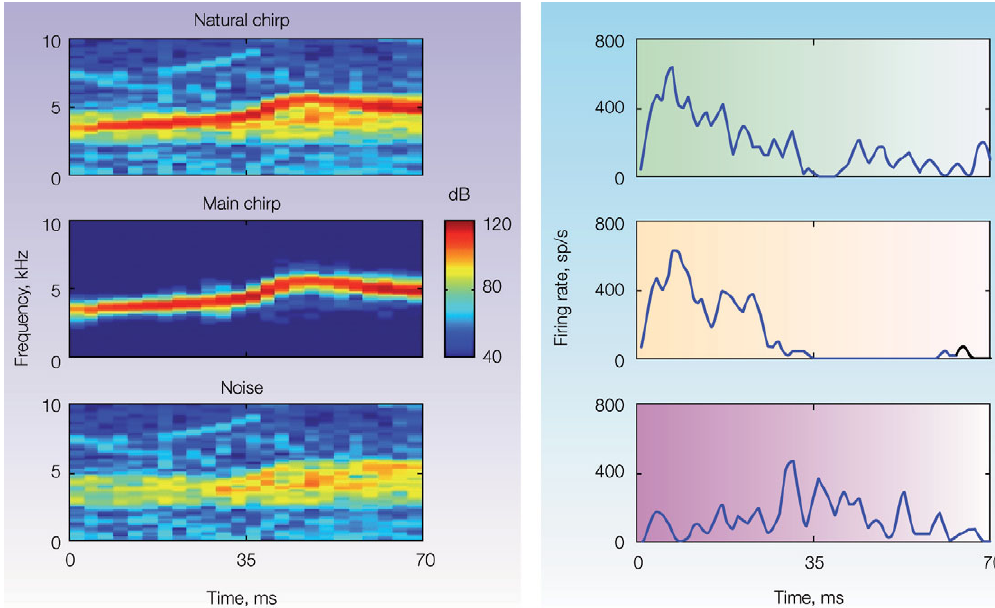
Figure 1 | Spectrograms (left) and peri-stimulus time histograms of the responses of a primary-like unit in the ventral cochlear nucleus of a cat (right). The stimuli were a segment of a natural sound consisting of a bird chirp and its natural background (top), the clean bird chirp (middle) and the background (bottom). These sounds have been used in Bar-Yosef and Nelken